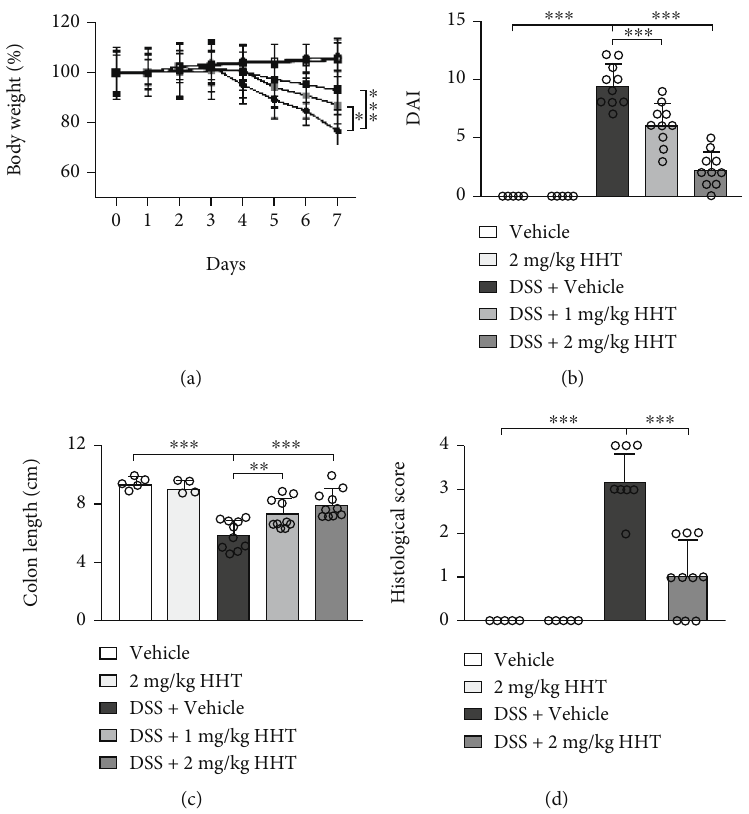
Figure 1: E ff ect of HHT on DSS-induced colitis in mice. Mice were treated with 3% DSS in autoclaved drinking water along with intraperitoneally injected vehicle, 1 mg/kg HHT, or 2mg/kg HHT for seven days: (a) bodyweight of mice; (b) DAI (disease activity index) on day 7; (c) colon length or mice on day 7; (d) histopathological scores from colon tissue sections of DSS-induced mice on day 7. Five mice per group. Error bar represents mean ± SD . ∗ p < 0 : 01 , ∗∗ p < 0 : 01 , and ∗∗∗ p < 0 : 001